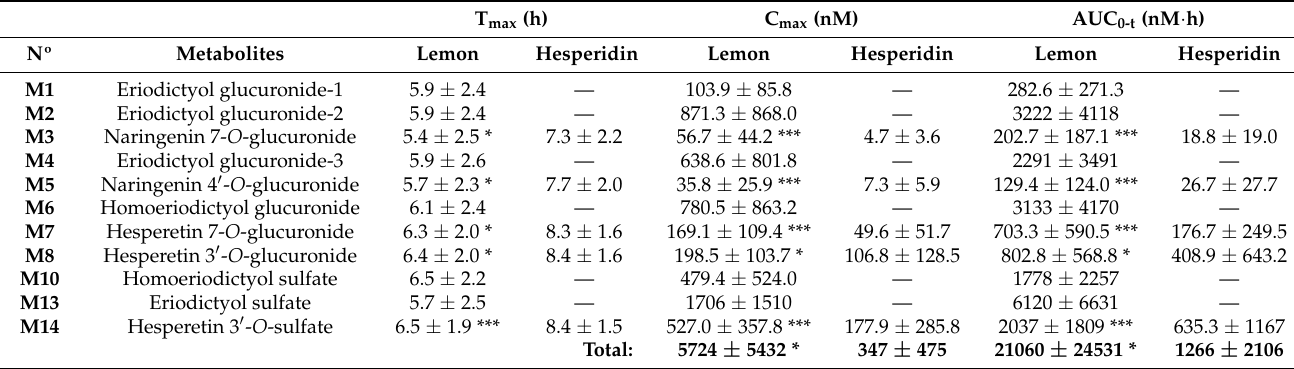
Nº , metabolite according to Figure 2 and Table 3; –, not determined; T max , time of maximum concentration; C max , maximum concentration; AUC 0-t , area under the curve from the time of dosing to the final quantifiable concentration. Asterisks designate a significant difference between consumption of lemon extract and hesperidin (* p < 0.05; *** p < 0.001). Similar to urine samples, volunteers 2, 7, and 12 showed the highest concentra- tions for these metabolites as well as for phase-II hesperetin metabolites after lemon and orange extract intake, respectively (Supplementary Figure S3). Remarkably, the nari- genin glucuronides M3 and M5 were also quantified in plasma after orange extract intake despite the extract lacked either naringin or naringenin. Similar to the urinary excre- tion, plasma metabolite concentrations also showed a high interindividual variability (Supplementary Figure S3). The mean values of maximum concentrations times (T max ) ranged from 5.4 to 6.5 h and 7.3 to 8.4 h after consuming lemon or orange extract, respectively. Overall, total plasma metabolites showed significantly mean lower T max (6.0 ± 0.3 vs. 8.0 ± 0.5 h) and higher consuming lemon vs. orange extract, respectively (Table 5) (C max and AUC values were significantly higher after consuming lemon vs. orange extract, taking into account the different amounts of flavanones consumed). Figure 3 shows the pharmacokinetic profiles of representative metabolites after con- suming lemon or orange extract. The previously mentioned high interindividual variability allowed us to stratify the volunteers into high and low metabolite producers. In this regard, Supplementary Figure S4 shows the plasma concentrations of M2 and M8 in a low producer (volunteer 6) vs. a high producer (volunteer 2). Remarkably, the higher plasma concentration detected after consuming lemon extract allowed the detection of both metabolites in both high- and low-producers, while M2 was detected after consuming orange extract in the high producer, but not in the low producer (Supplementary Figure